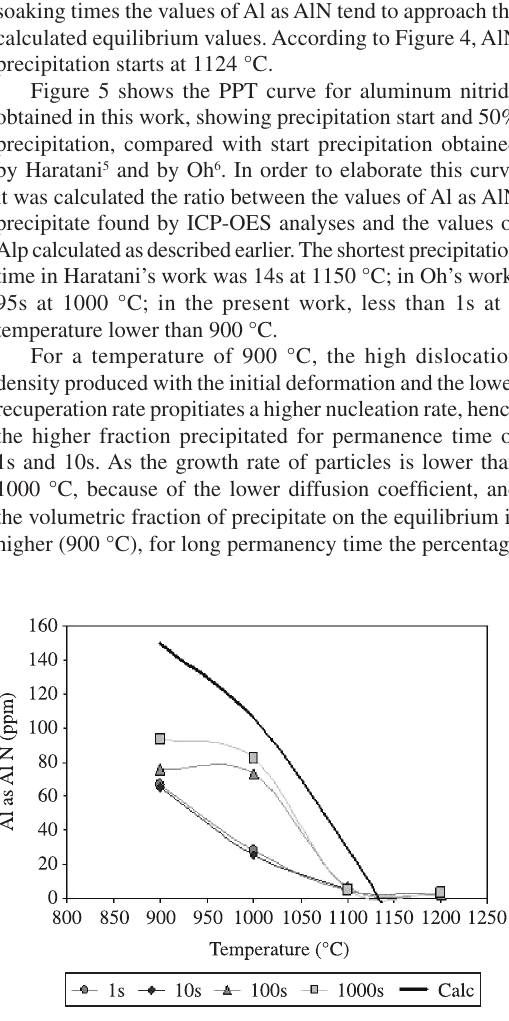
Figure 4. The content of Al as AlN precipitate for the different test temperatures and soaking times.